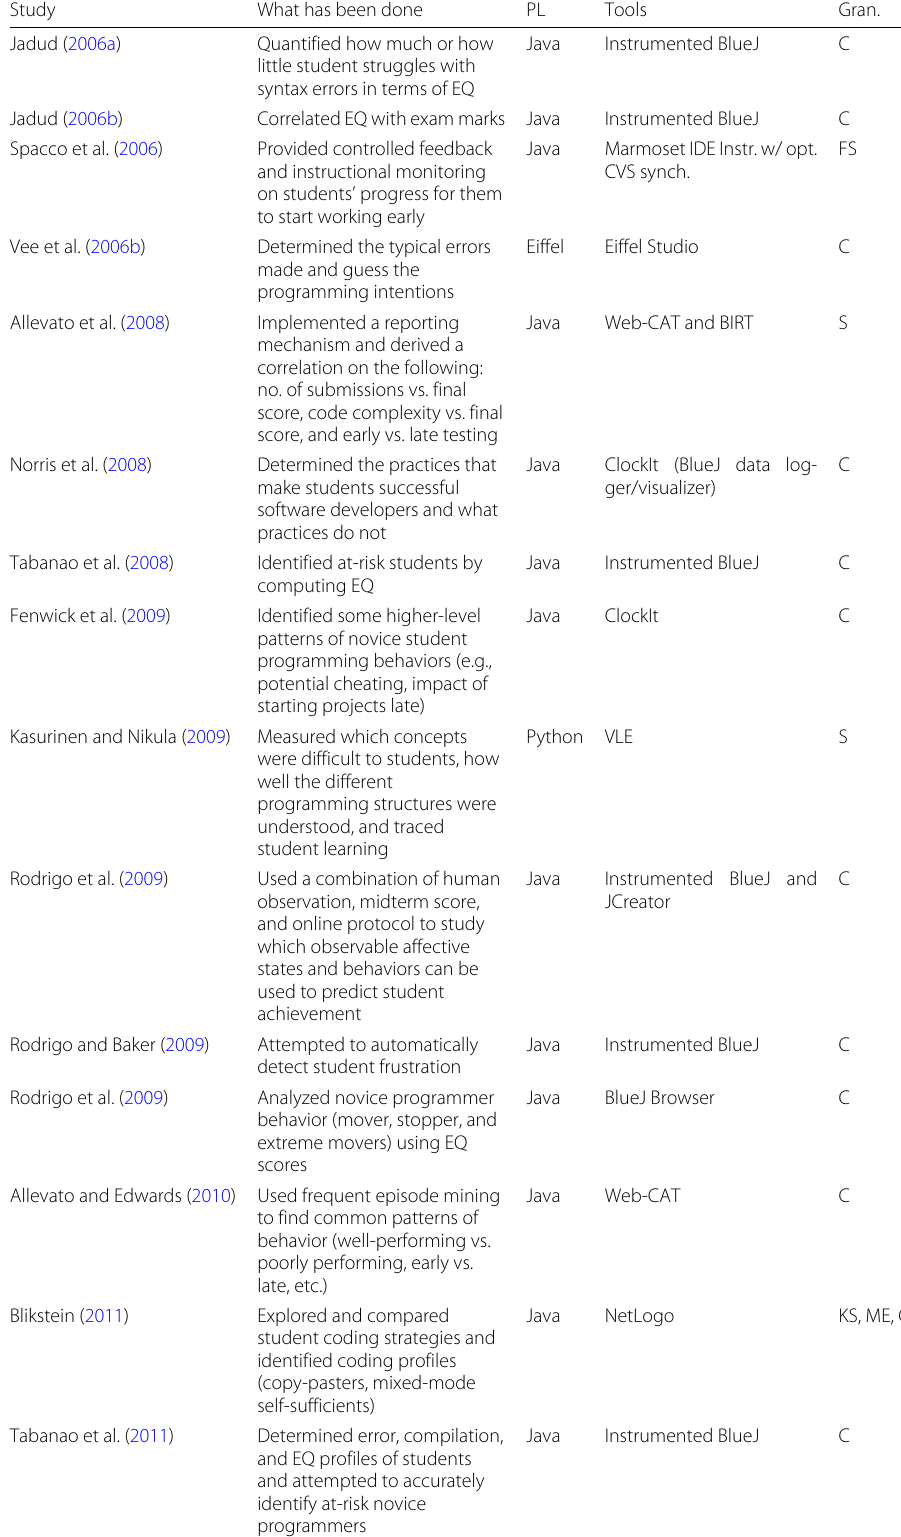
Table 1 Studies conducted using a process-oriented approach in the context of novice